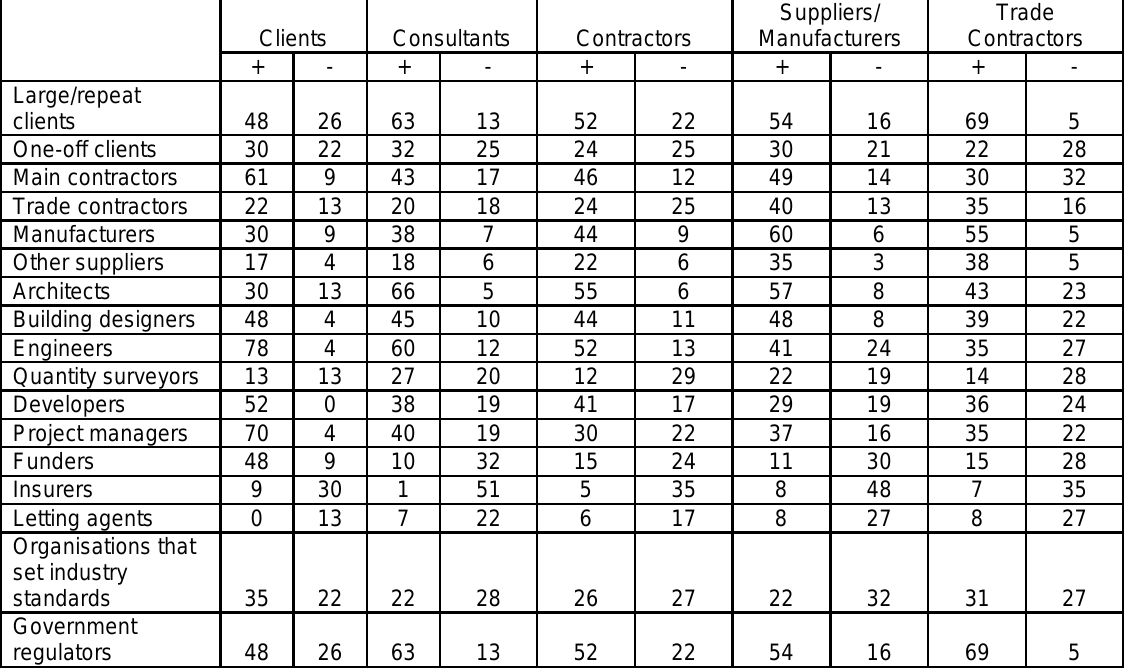
Table 2 : Perceived Encouragers and Blockers of Innovation by Sector